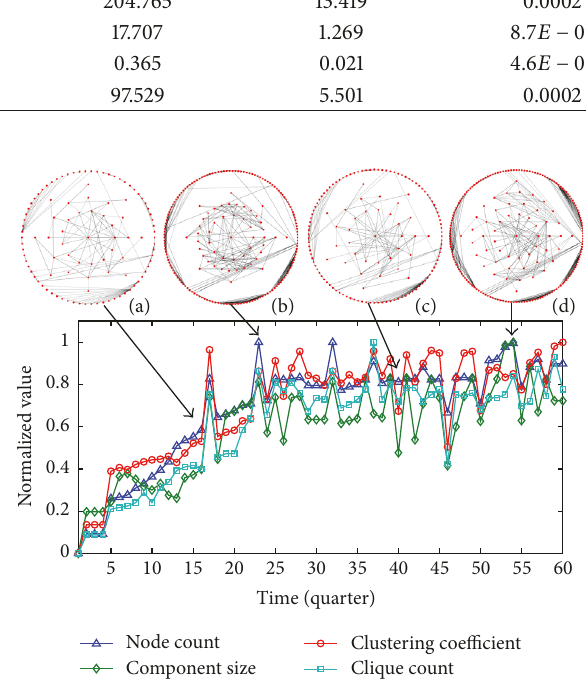
Figure 4: Trends of the extracted features of Al-Qaeda networks. The four measures are normalized within [0,1] . (a), (b), (c), and (d) are examples of network snapshots with IDs of GN 16 , GN 23 , GN 40 , and GN 54 , while GB 16 = 0 , GB 23 = 1 , GB 40 = 0 , and GB 54 = 1